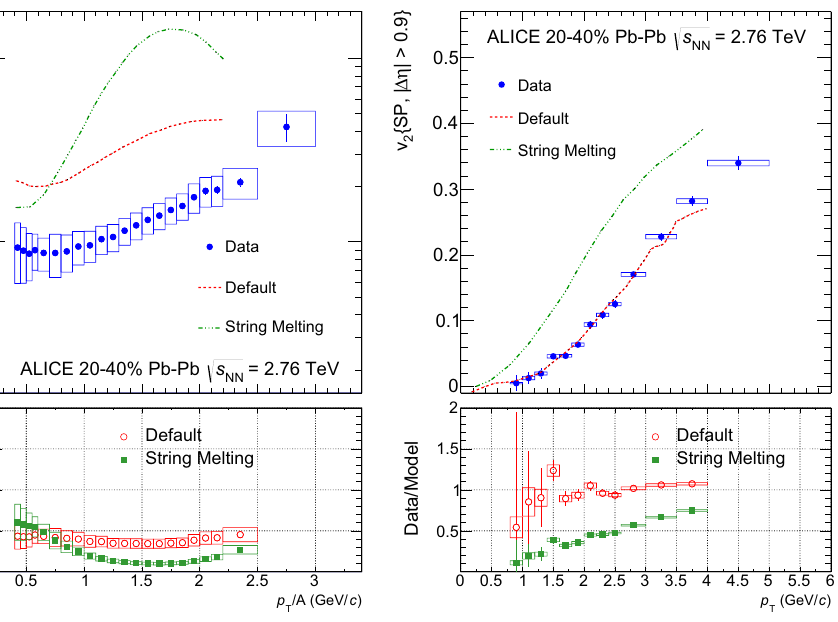
Fig. 9 Measured deuteron (filled dots) B 2 as a function of the trans- versemomentumpernucleon( p T /A)(topleftpanel)and v 2 ( p T )param- eter (top right panel) compared to those produced with two versions of